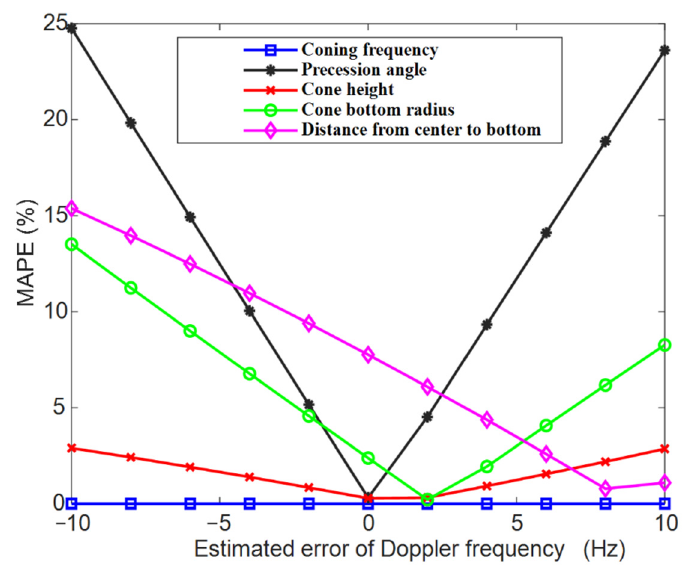
Figure 20. MAPE of five parameters with different estimation errors of micro-Doppler frequency.